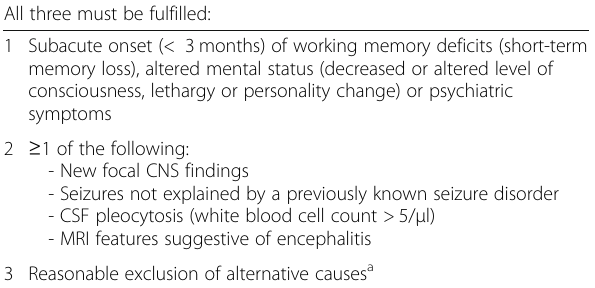
Table 2 Criteria for “ possible autoimmune encephalitis